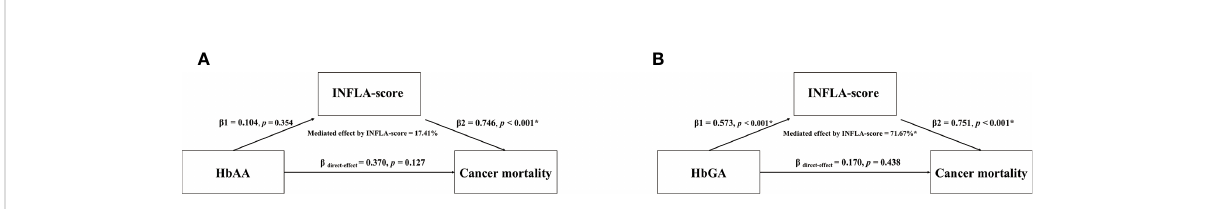
FIGURE 2 Mediated effects of INFLA-score on the association between HbAA (A) and HbGA (B) and cancer mortality. Mediation analysis was adjusted for age, sex (male/female), race (Mexican American, other Hispanic, non-Hispanic white, non-Hispanic black or other races), regular exercise (yes/ no), body mass index (BMI), education (< 9th Grade, 9-11th Grade, High School Grade, GED or Equivalent, Some College or AA degree, College Graduate or above), income (< $20,000, $20,000-$45,000, $45,000-$75,000, $75,000-$100,000 or > $100,000), current smoker (yes/no), current drinker (yes/no), energy (kcal/d), cotinine (ng/ml), diabetes (yes/no), hypertension (yes/no), dyslipidemia (yes/no) and INFLA-score. b 1, the indirect effect of AA biomarkers on INFLA-score; b 2, the indirect effect of INFLA-score on cancer mortality; b direct-effect , the direct effect of AA biomarkers on cancer mortality; *p <